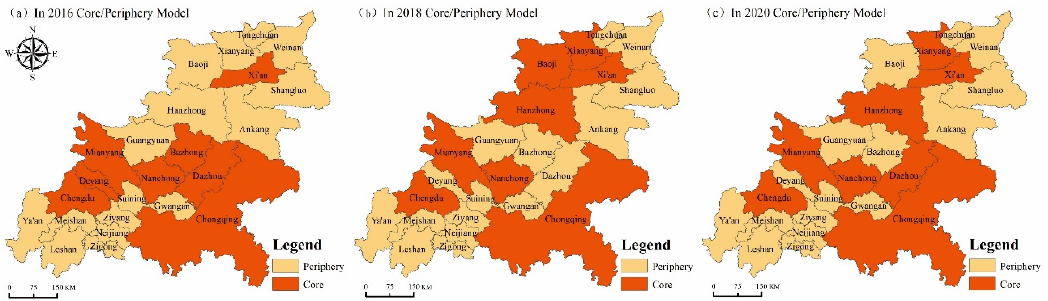
Figure 3. The core/periphery pattern of cultural tourism Internet attention in WTEZ: ( a ) 2016; ( b ) 2018; ( c ) 2020.